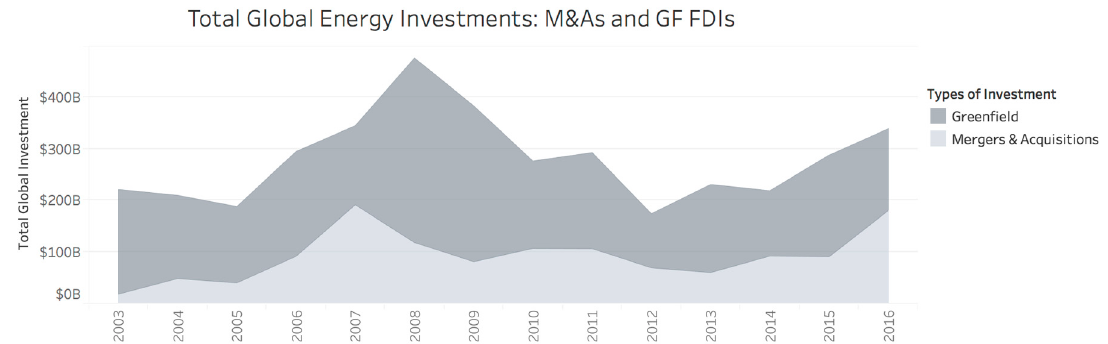
Figure 9. Total energy FDI, split by M&A and GF FDI. GF and M&A dropped following the global recession and have recovered since 2015. The highest GF was around 2008.